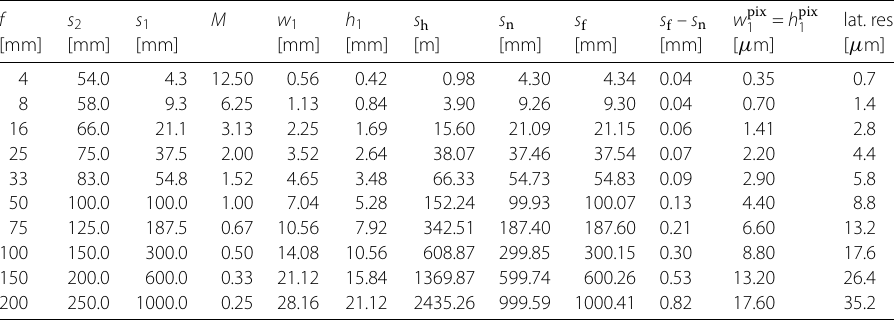
Table 2 Calculated performance parameters of a telemicroscope in dependence on the focal length (extension tube length: l = 50 mm; f-number: N = 2.8; sensor size: 7.04 mm × 5.28 mm; pixel size: 4.4